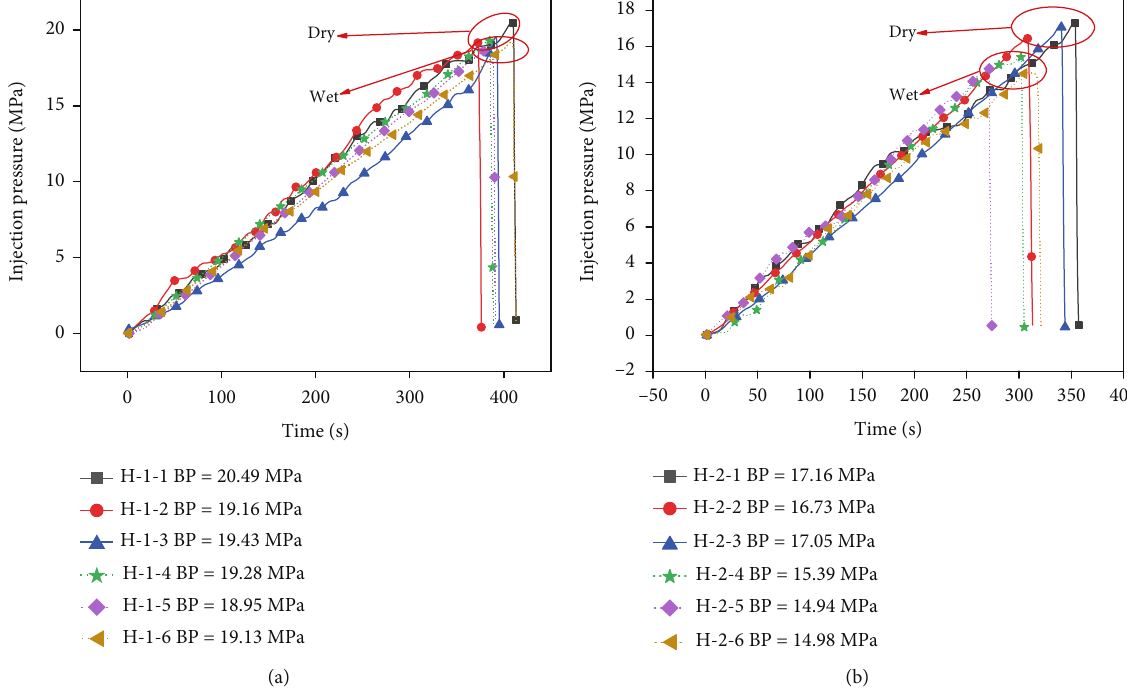
Figure 10: The nitrogen fracturing curves of dry and saturated vertical bedding shales under 3 MPa con fi ning pressures with and without injection: (a) without LN injection; (b) with LN LN 2 2 2